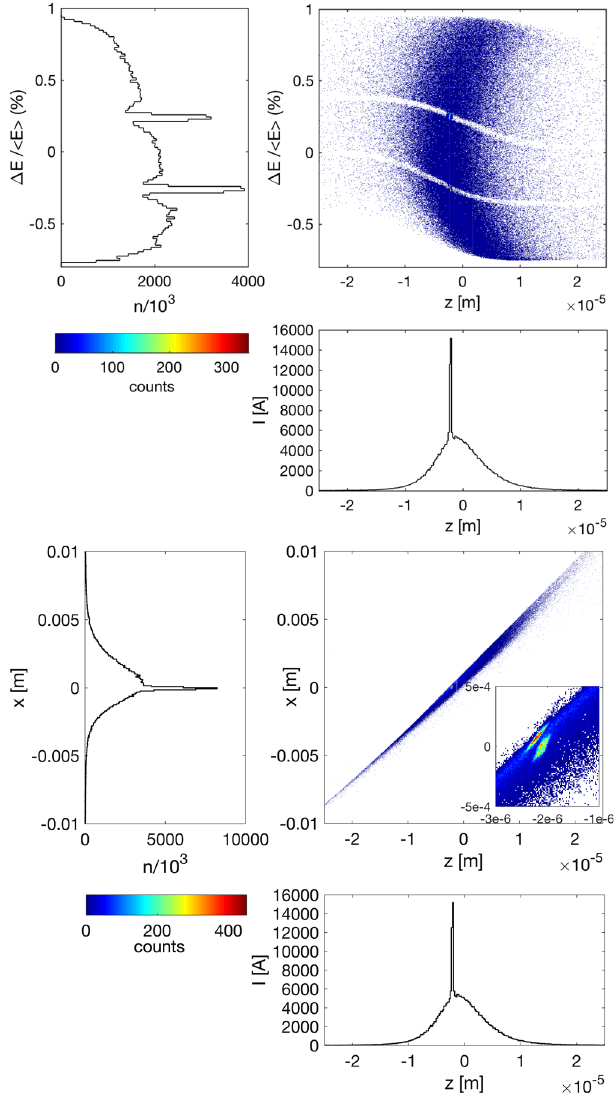
FIG. 9. Top: longitudinal phase space of the electron beam at the entrance of the undulators to generate two simultaneous pulses with a 1% color separation. Bottom: the two slices with preserved emittance are transversely aligned with the undulator axis and separated from the rest of the